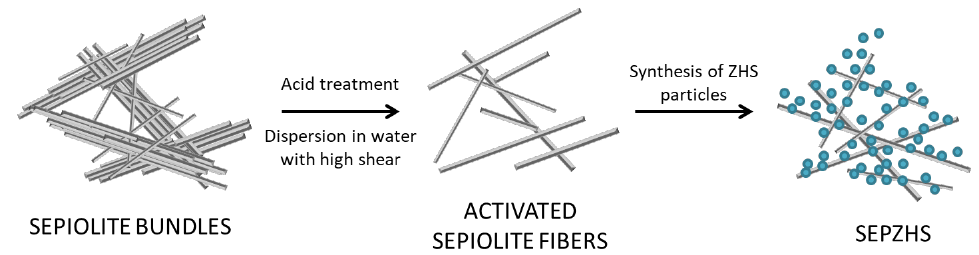
Figure 1. Scheme for the sepiolite additive with ZHS nanoparticles preparation.